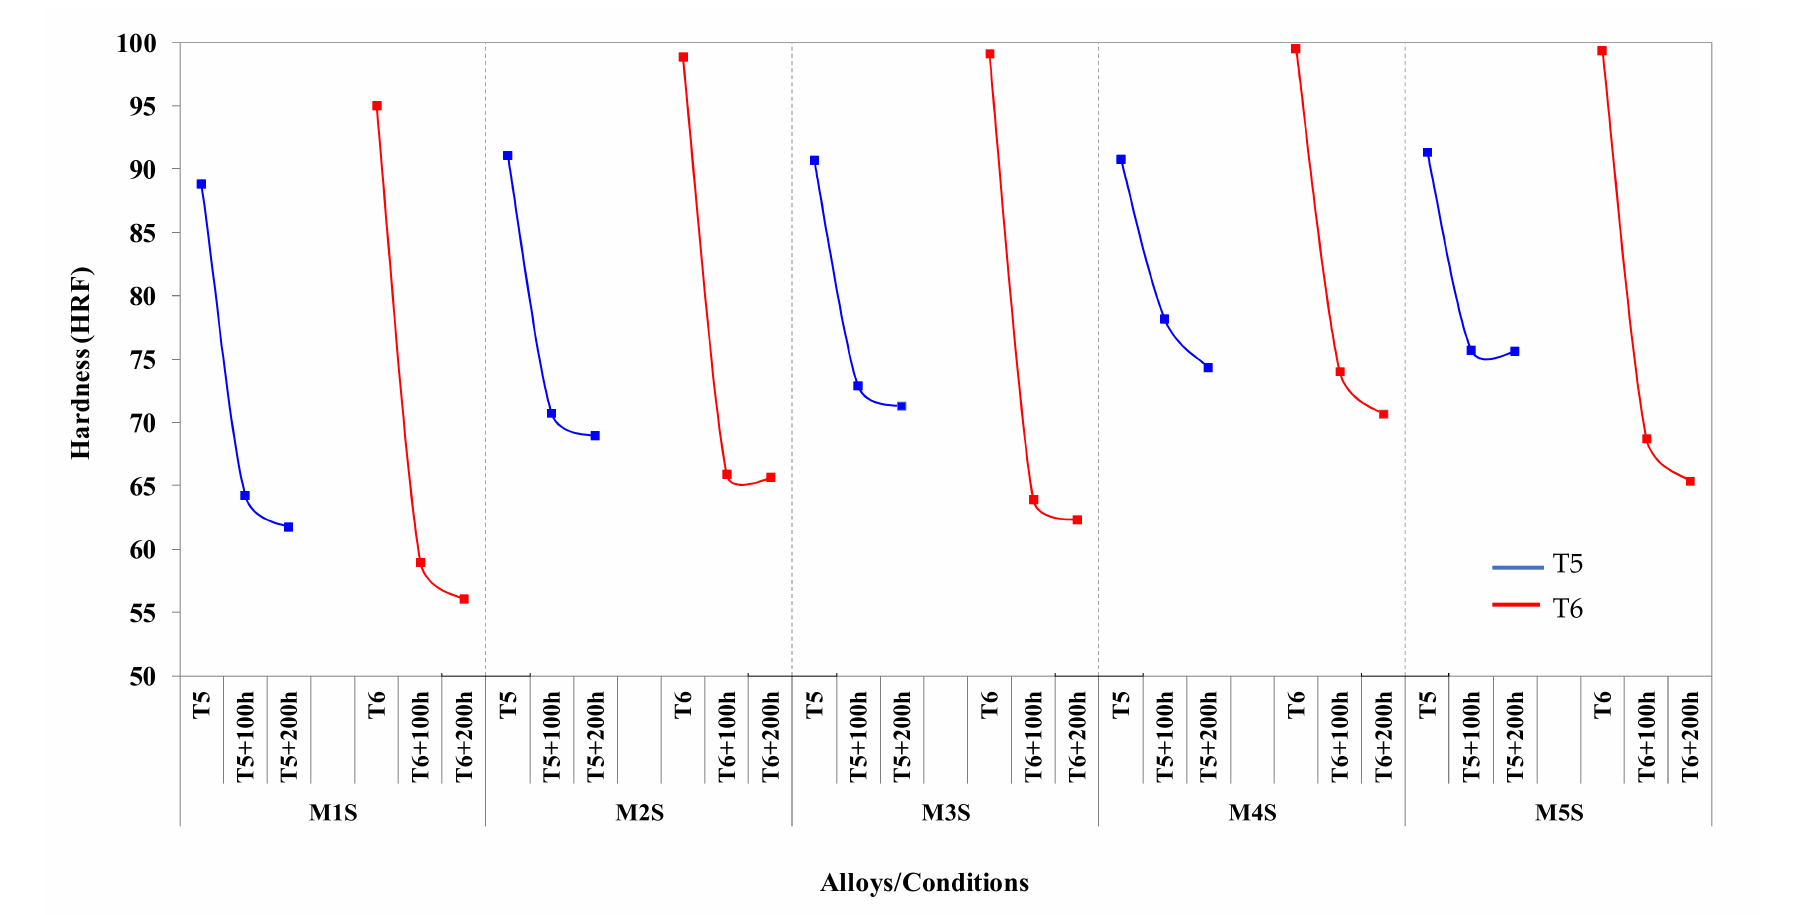
Figure 3. Variation in average Rockwell hardness values for alloys M1S through M5S in the T5 and T6 conditions, and after static stabilization at 250 ◦ C for 100 h and 200 h (testing at ambient